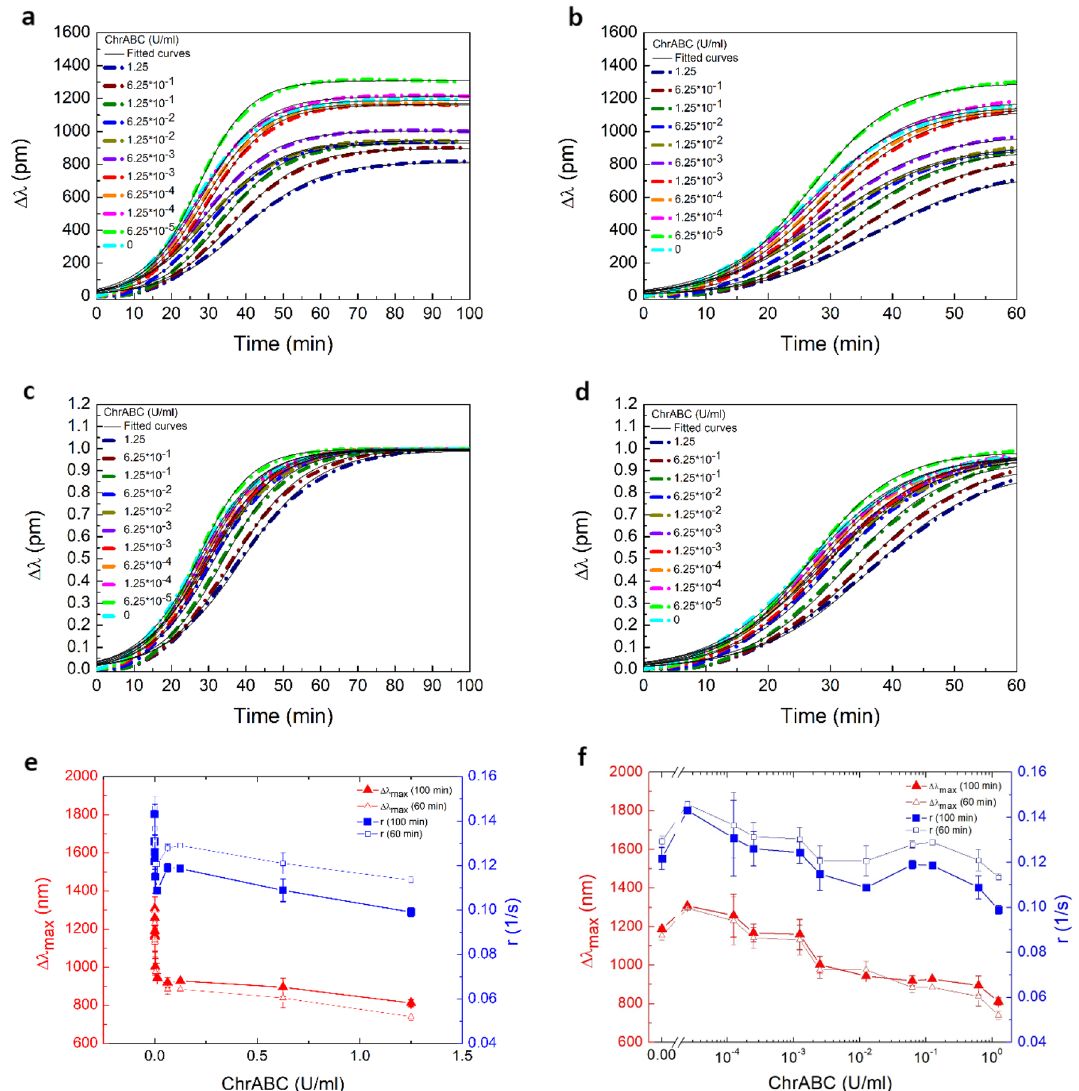
Figure 5. ( a , b ) Measured cell adhesion kinetic curves in the presence of ChrABC with 11 different concentrations. The curves were fitted with the logistic equation at the 0–100 min ( a ) and 0–60 min ( b ) time intervals. The fitted black lines are perfectly follow the experimental data. ( c , d ) Measured cell adhesion kinetic curves for ChrABC enzyme treatment at various enzyme concentrations normalized to the maximum adhesion signal. The curves were fitted with logistic equation, and their slopes were compared at 0–60 min ( c ) and 0–100 min ( d ) time ranges. ( e , f ) Enzyme concentration dependence of (cid:31) (cid:31) max and r parameters obtained from the fits. Both linear ( e ) and logarithmic ( f ) axes are presented. As the fitting was performed both for 0–60 min and 0–100 min time intervals, two data sets are shown for each